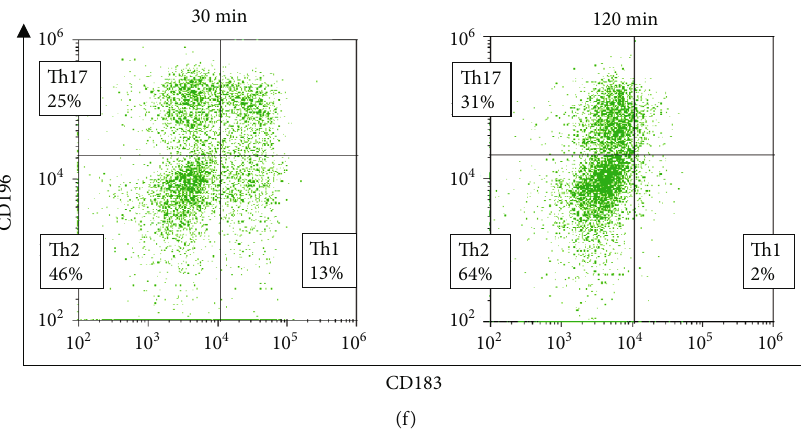
Figure 3: NDGs downregulate the Th1 marker CD183 on T-cells. T-cells were cultured together with NDGs for 0.5 – 5 hours, and T-cell subsets were evaluated at di ff erent time-points. NDGs did not change the percentage of (a) CD4 + cells and (b) CD8 + cells. However, the percentage of (c) Th1 cells decreased, and the percentage of (d) Th2 and (e) Th17 cells increased. (f) Subsets of T helper cells were distinguished based on their expression of CD196 and CD183. Graphs (a) – (e) show the median of 5